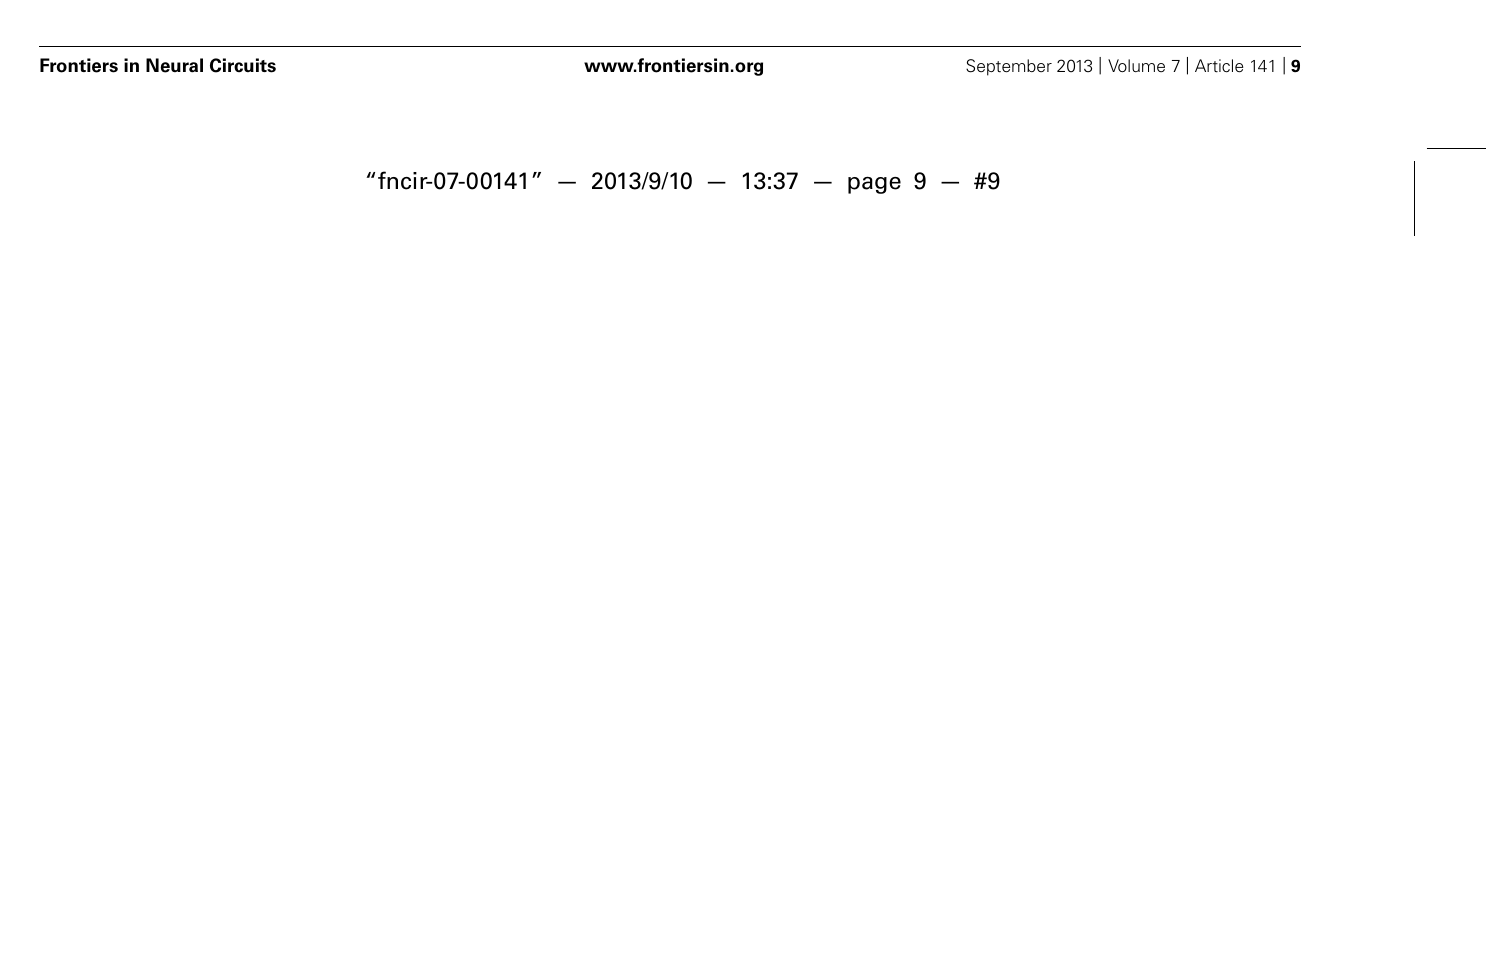
positive slope were omitted. Note the upward shift of points toward less negative values in the middle graph, corresponding to a flattening of the decay currents. (E) Comparison of the current decay slopes in the control condition with those in the presence of NO-711.The blue line depicts the AUROC values stemming from an amplitude-matched comparison of the current slope values shown in (D) (bin size was 0.25 nA). Shaded area corresponds to bin-wise 95% confidence intervals.The “zero effect” value of AUROC at 0.5 is marked with a dashed line. (F) Summary statistics for five 1000 nM NO-711. Black dots are estimates of the holding current averaged in 200 ms-intervals; width and height of gray bars represent duration and amplitude averaged over duration, respectively, of phasic currents. Note the different amplitude